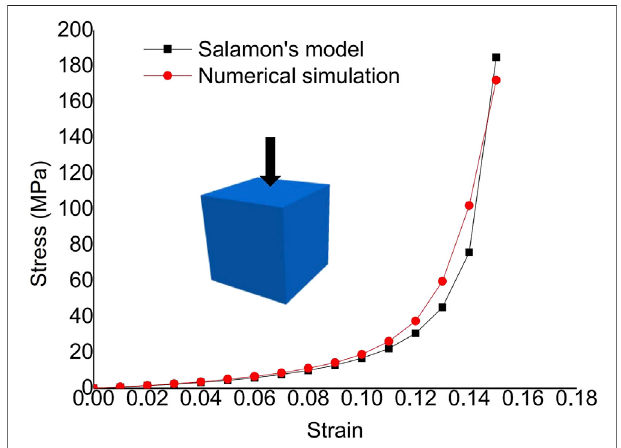
FIGURE 3 | Stress – strain curve comparison between Salamon theoretical analysis and numerical simulation.